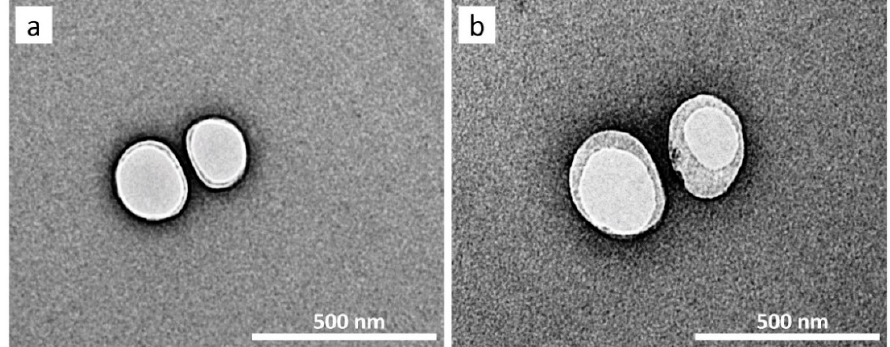
Figure 2. TEM images of ( a ) PNs-LipoDV and ( b ) PNs-LipoDV-MPLA, scale bar 500 nm.